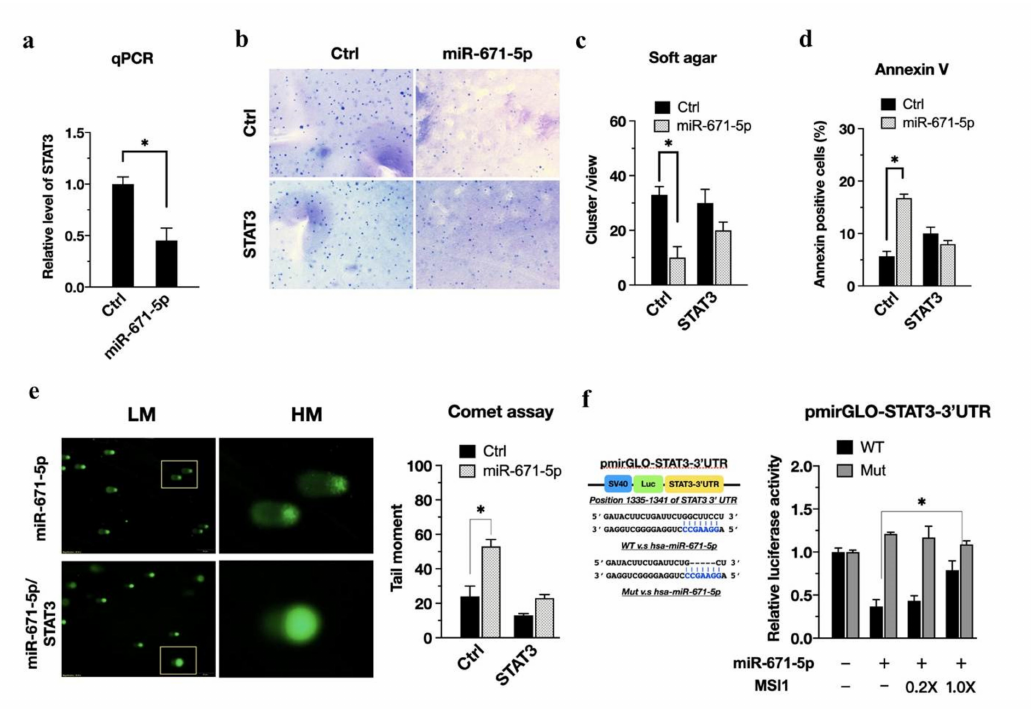
Figure 3. miR-671-5p suppresses STAT3 to activate radiosensitivity, but MSI1 rescues U87MG cells via inhibition of this mir-671-5p/STAT3 axis. ( a ) qRT-PCR analysis of STAT3 expression in miR-671- 5p-overexpressed U87MG cells. GAPDH was used as a loading control. The mRNA level is compared to the control group, quantified relative to the vehicle group, and presented as a mean from three independent experiments with SD error bars. An asterisk indicates a statistically significant difference (Student’s t -test, p < 0.01). ( b ) Soft agar colony-formation assay of U87MG cells transfected with miR- 671-5p, STAT3, miR-671-5p/STAT3, or control plasmid, and ( c ) quantification of the colony number in each group. ( d ) Flow cytometry annexin V assay and ( e ) comet assay of control, miR-671-5p-, STAT3, miR-671-5p/STAT3 overexpressed cells after 3 Gy irradiation. ( f , left) A scheme presentation of pmirGLO-STAT3-3 (cid:48) UTR map. The 3 (cid:48) UTR of STAT3 has the binding sites for miR-671-5p. ( f , right), luciferase reporter assay for the direct interaction of miR-671-5p with predicted target sites in the 3 (cid:48) UTRs of STAT3. The MSI1 overexpression attenuated the inhibition of luciferase activities by miR- 671-5p. The U87MG cells were transfected with different doses of MSI1 plasmid (empty, 0.2X, and 1X). The luciferase activity is normalized to Renilla and presented as the mean from three independent experiments with SD error bars. An asterisk indicates a statistically significant difference (Student’s t -test, * p <